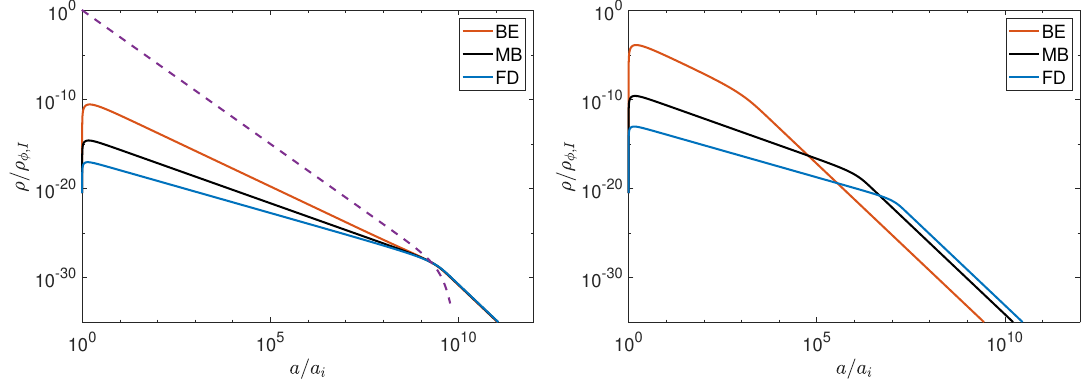
Figure 1. Left panel: energy density as a function of scale factor during reheating for (cid:0) 0 = 10 (cid:0) 14 M (cid:30) , (cid:26) (cid:30);I = M 2 M 2 , and M (cid:30) = 2 : 4 (cid:2) 10 5 GeV. Solid lines show the energy density of a Pl (cid:30) thermal radiation bath with di(cid:11)erent colors indicating di(cid:11)erent statistics: orange for Bose-Einstein (BE), black for Maxwell-Boltzman (MB) and blue for Fermi-Dirac (FD). The energy density in the in(cid:13)aton (cid:12)eld is shown by the purple dashed line. Right panel: same as the left panel, with in(cid:13)aton width given by (cid:0) 0 = 10 (cid:0) 9 M (cid:30) . For these parameters the reheat temperature is larger than the in(cid:13)aton mass and hence di(cid:11)erent quantum statistics lead to di(cid:11)erent reheat temperatures. Bosonic